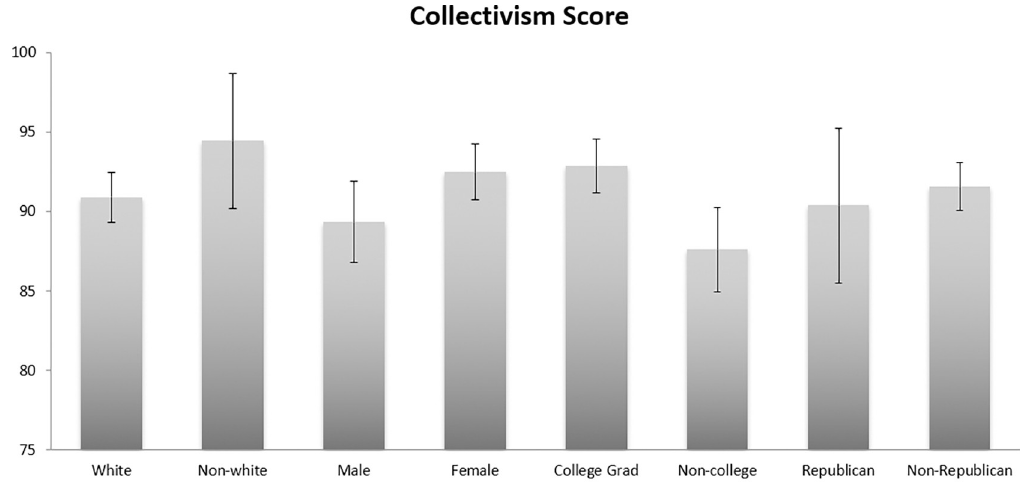
Fig 1. Mean collectivism scores by demographic groups with 84% confidence intervals. Fig 1 shows the mean Collectivism scores for various demographic groups in the study, with 84% confidence intervals which are appropriate for visualizing differences that are significant at the p < 0.05 level [69]. The theoretical range of the Collectivism scale is 16–144, and the observed range was 61–130. Female respondents are more collectivist than male respondents and those with a college degree are more Collectivist that those without a degree, and these differences are significant at the p < .05 level (two-tailed tests). Race difference is marginally significant at p < .10, which does suggest a meaningful difference given the small sample size of non- white respondents.